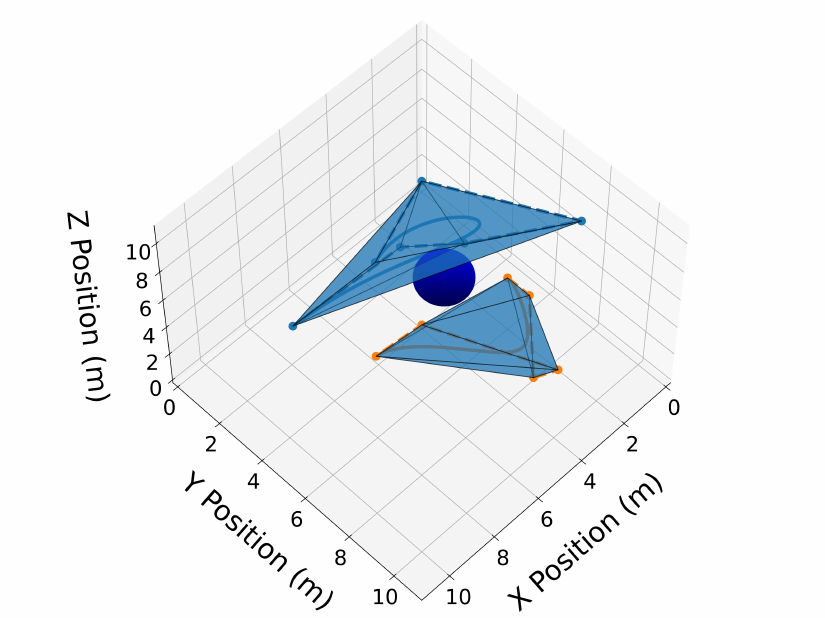
Figure 12. 3D convex hulls drawn as transparent blue surfaces around the Bernstein coefficients of trajectories C [ 3 ] ( t ) and C [ 4 ] ( t )